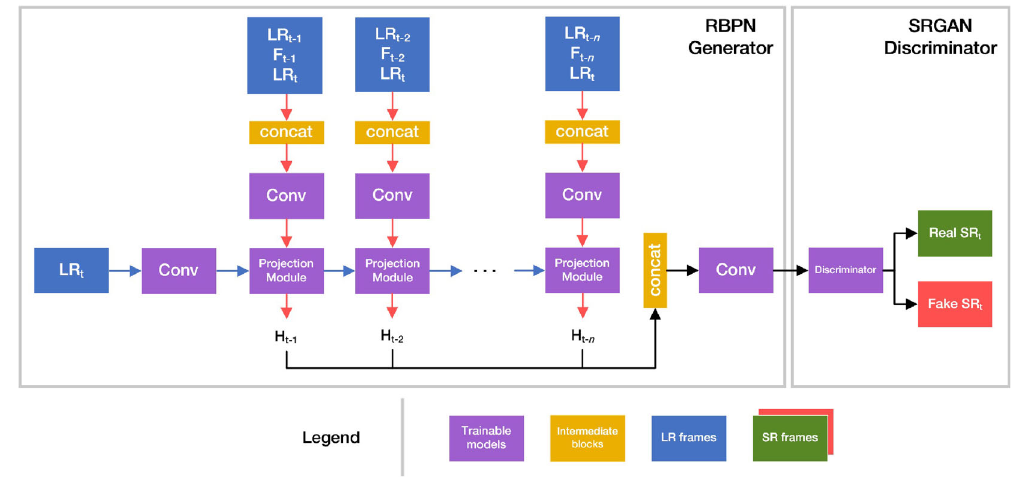
Fig. 2 Overview of